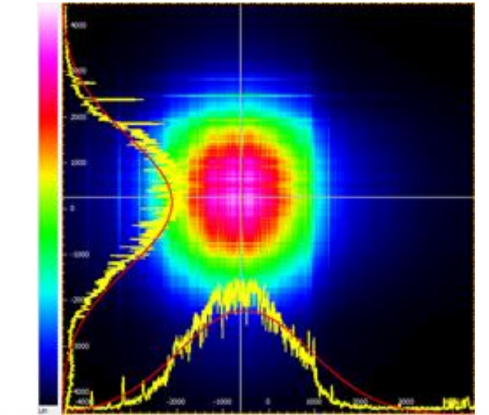
Figure 6. Beam profile of the output signal light.